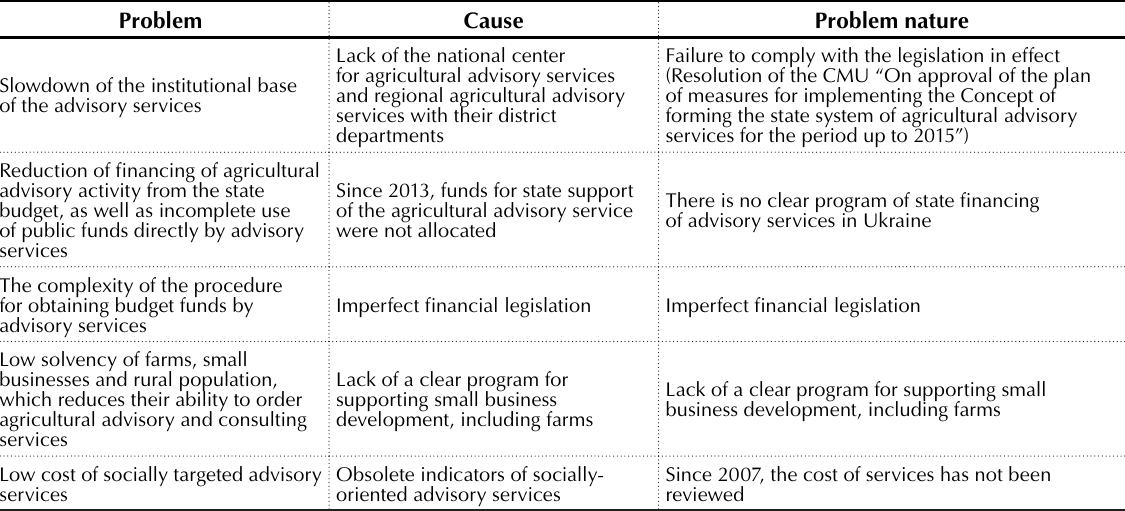
Table 1. Main problems and causes of advisory development inhibition in the agrarian sector of the Ukrainian